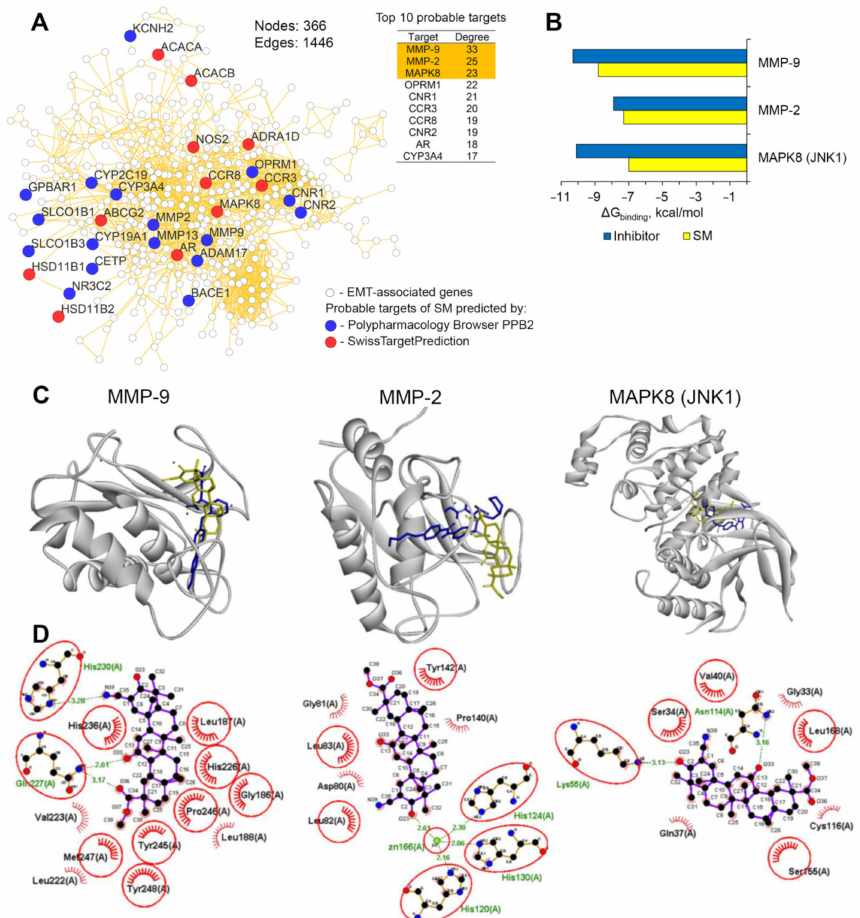
Figure 7. Network pharmacology revealed c-Jun N-terminal protein kinase 1 (JNK1) and matrix metalloproteinases 2 and 9 (MMP-2 / -9) as probable primary targets of SM, associated with its